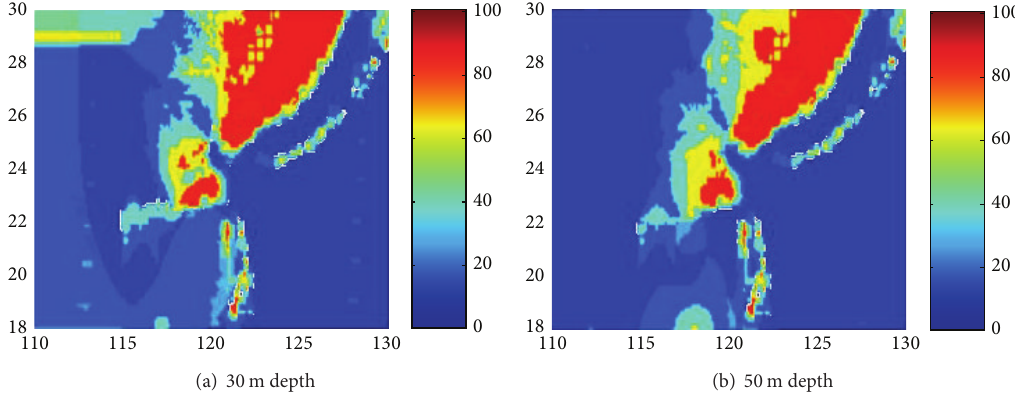
Figure 2: Safety situation (February).